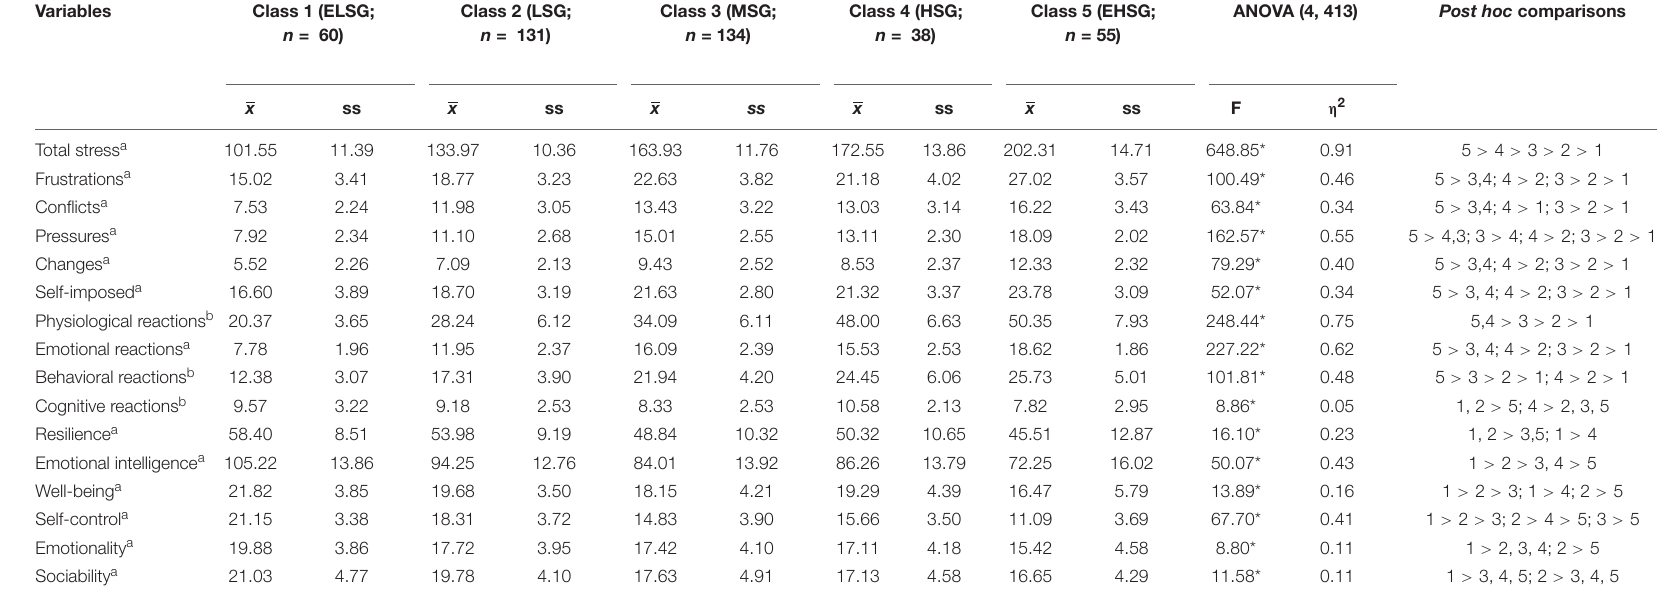
TABLE 3 | The differences of five classes in terms of the study variables: Descriptive statistics, results of ANOVAs, and post hoc comparisons.